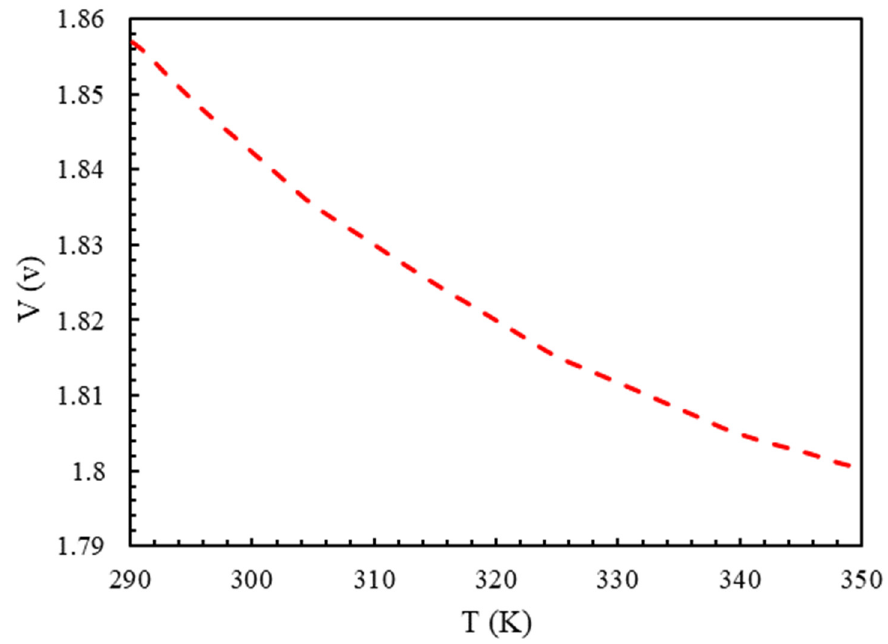
Figure 8. The effect of temperature on the electrolyzer’s cell voltage with a current density of 5000 A/m (cid:2870) , 2 , P = 1 bar, electrode catalyst of platinum, and membrane of 𝑃 = 1 bar , electrode catalyst of platinum, and membrane of Nafion. 5000 A/m